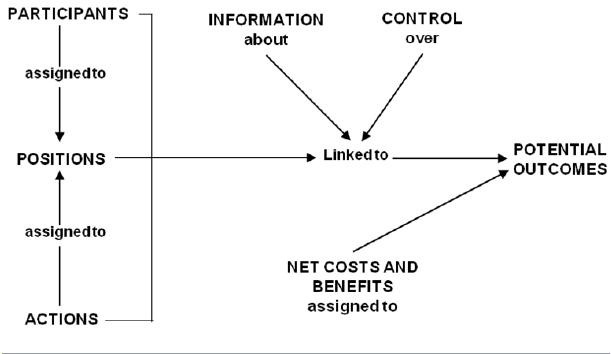
Fig. 3 . The action situation of the institutional analysis and development framework. Adapted from Ostrom